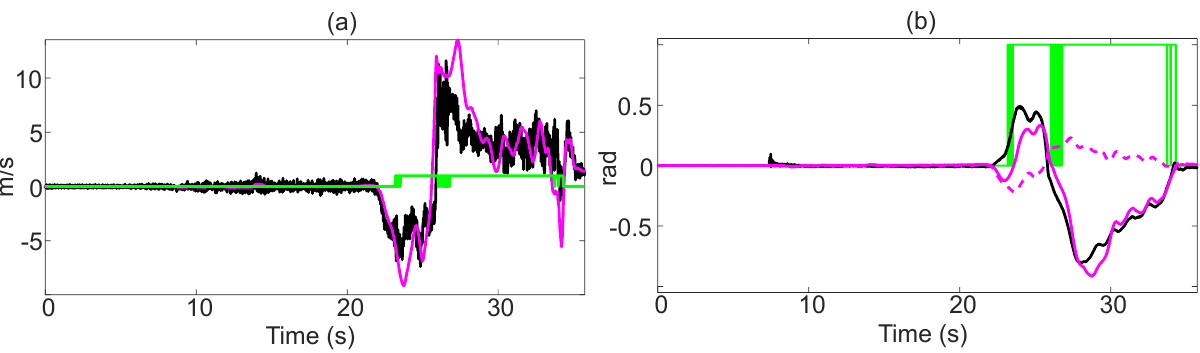
Figure 13. Shown are ( a ) the drift bit (green), the estimated (black) and expected (magenta) lateral acceleration, ( b ) the drift bit (green), the measured (black) and estimated (magenta solid, magenta dashed) sideslips. Drift bit = 1 means